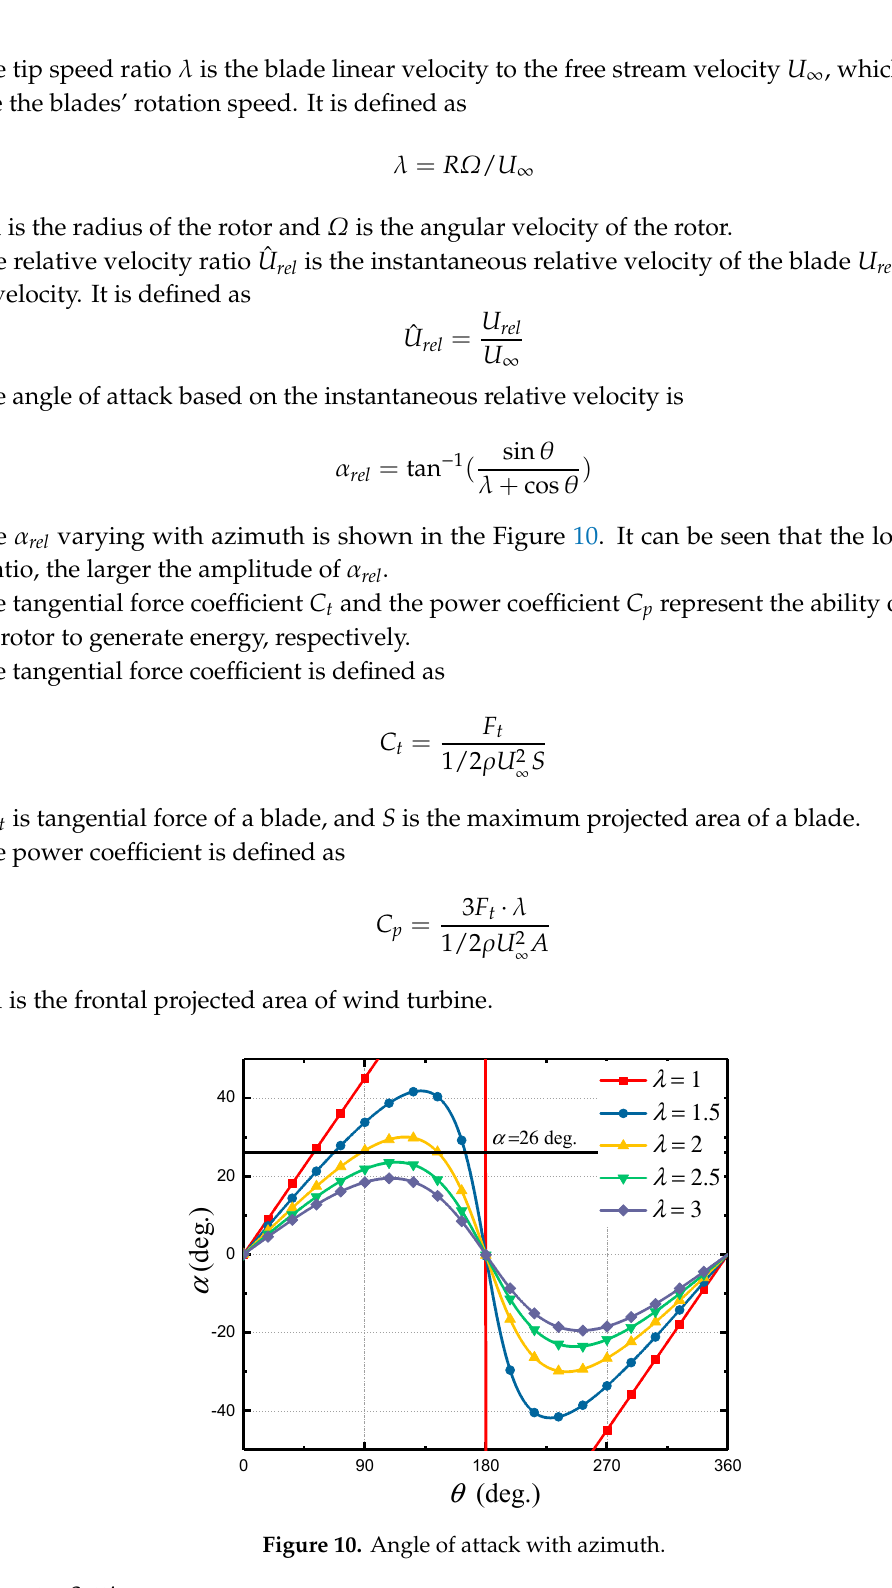
Table 1. Parameters of the simulations.